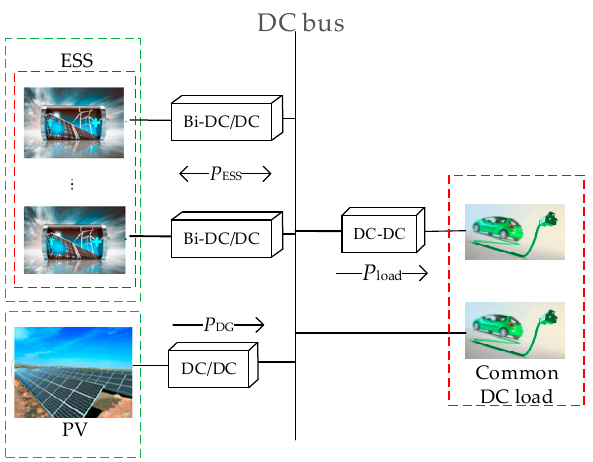
Figure 1. Structure of the island DC microgrid.